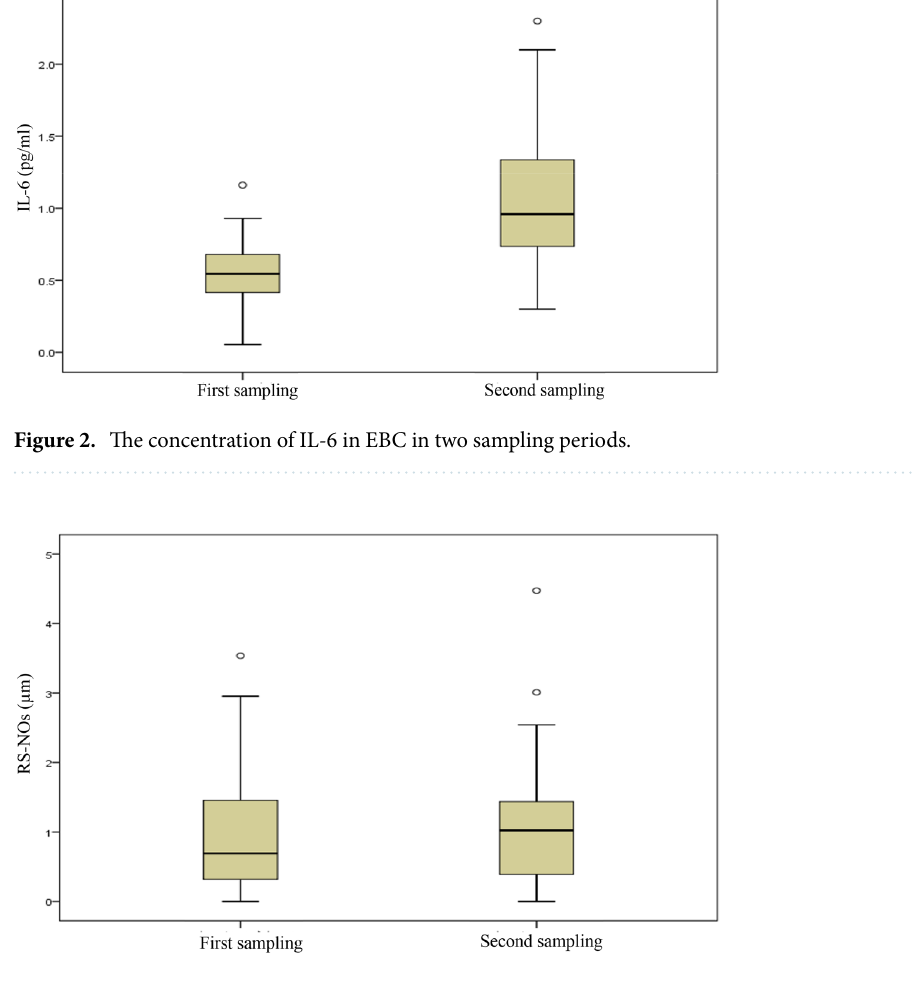
Figure 3. The concentration of RS-NOs in EBC in two sampling